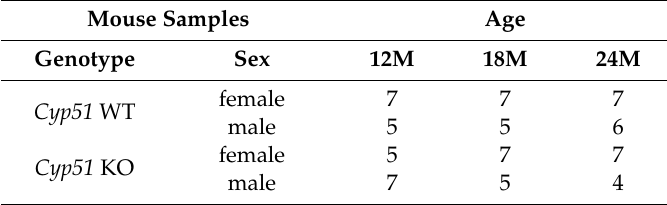
Table A2. Number of mouse samples for plasma and RT-qPCR gene expression analysis.